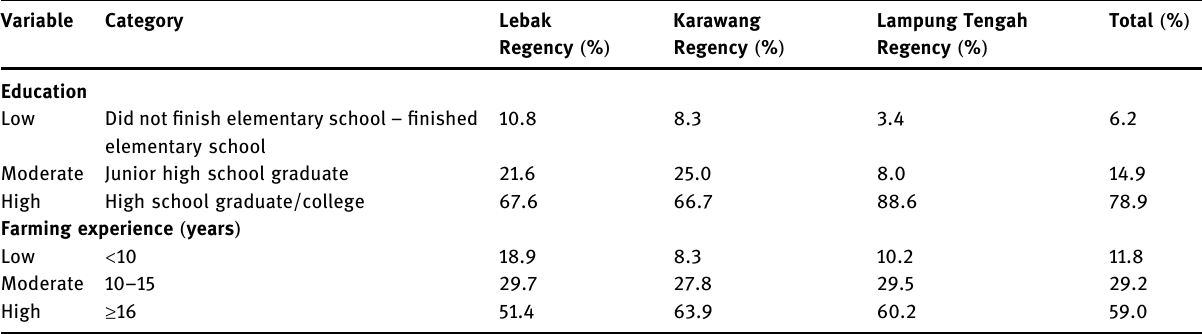
Table 2: Characteristics of IAE workers at the research site, 2021 Variable